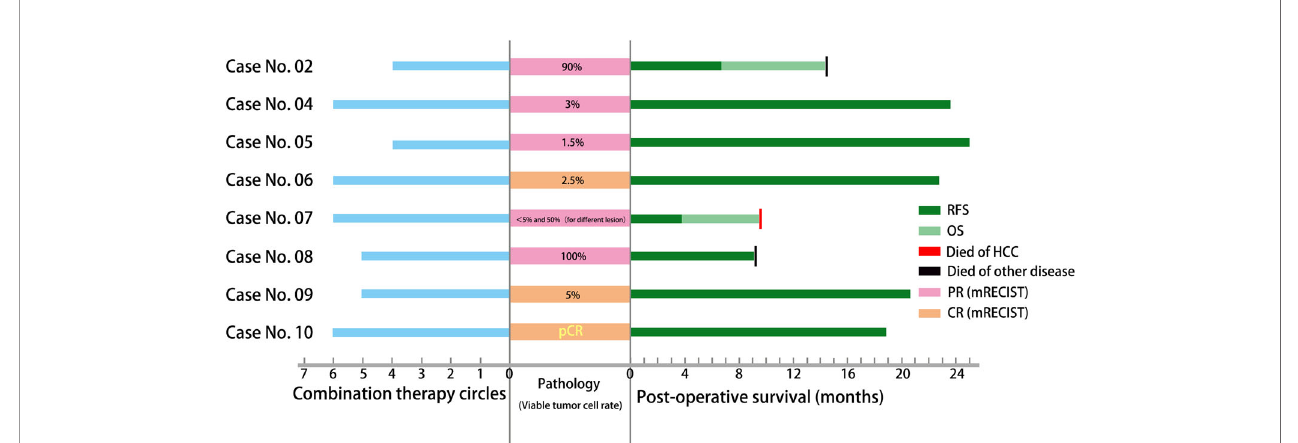
FIGURE 4 | General view of combination therapy, surgery, pathology, and post-surgery survival.